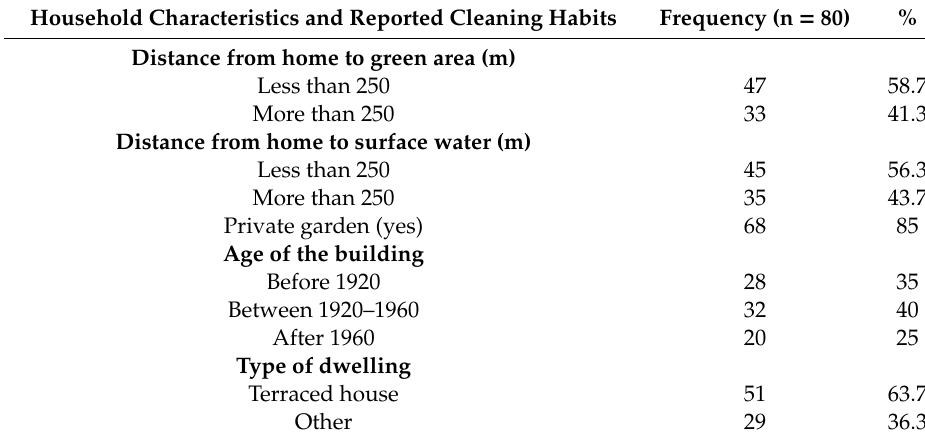
Table 2. Household characteristics and reported cleaning habits of participants in this study (n =